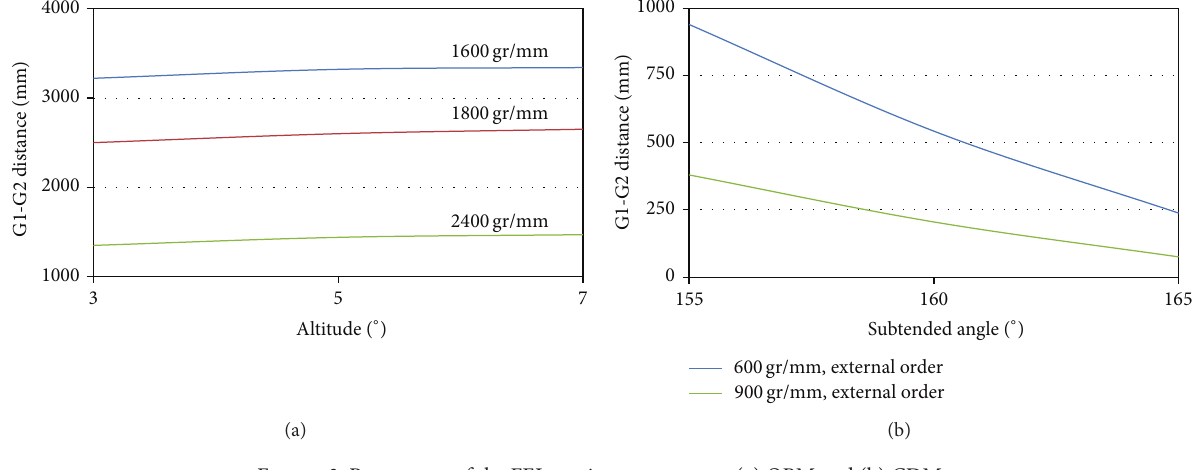
Figure 3: Parameters of the FEL grating compressor: (a) OPM and (b) CDM.